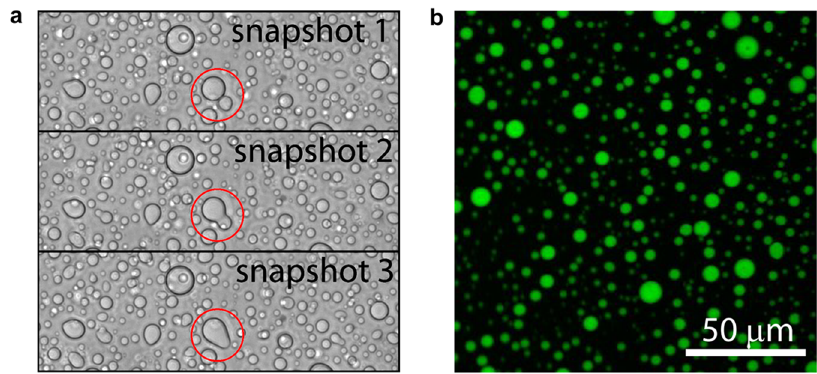
Fig 4. Tau and RNA forms droplet in vitro. (A) Bright field snapshotsof dropletsfrom 400 μ M Δ tau187and 800 μ g/ml poly(A) showing2 droplets seamlessly fusing (highlightedwith red circle). (B) Confocal microscopy image of Δ tau187labeledwith Alexa-488of the droplets from the same sample as in (A). 50 μ M Alexa-488 labeled Δ tau187 mixed with 350 μ M MTSL labeled Δ tau187 of droplets formed immediately after adding 800 μ g/ml poly(A) RNA. Both (A) and (B) were sampledat room temperature and without added NaCl.